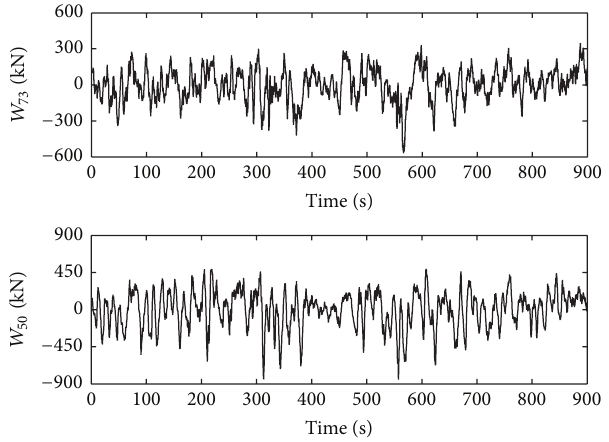
Figure 4: Time history of wind force on the 50th and 73rd storeys [22].